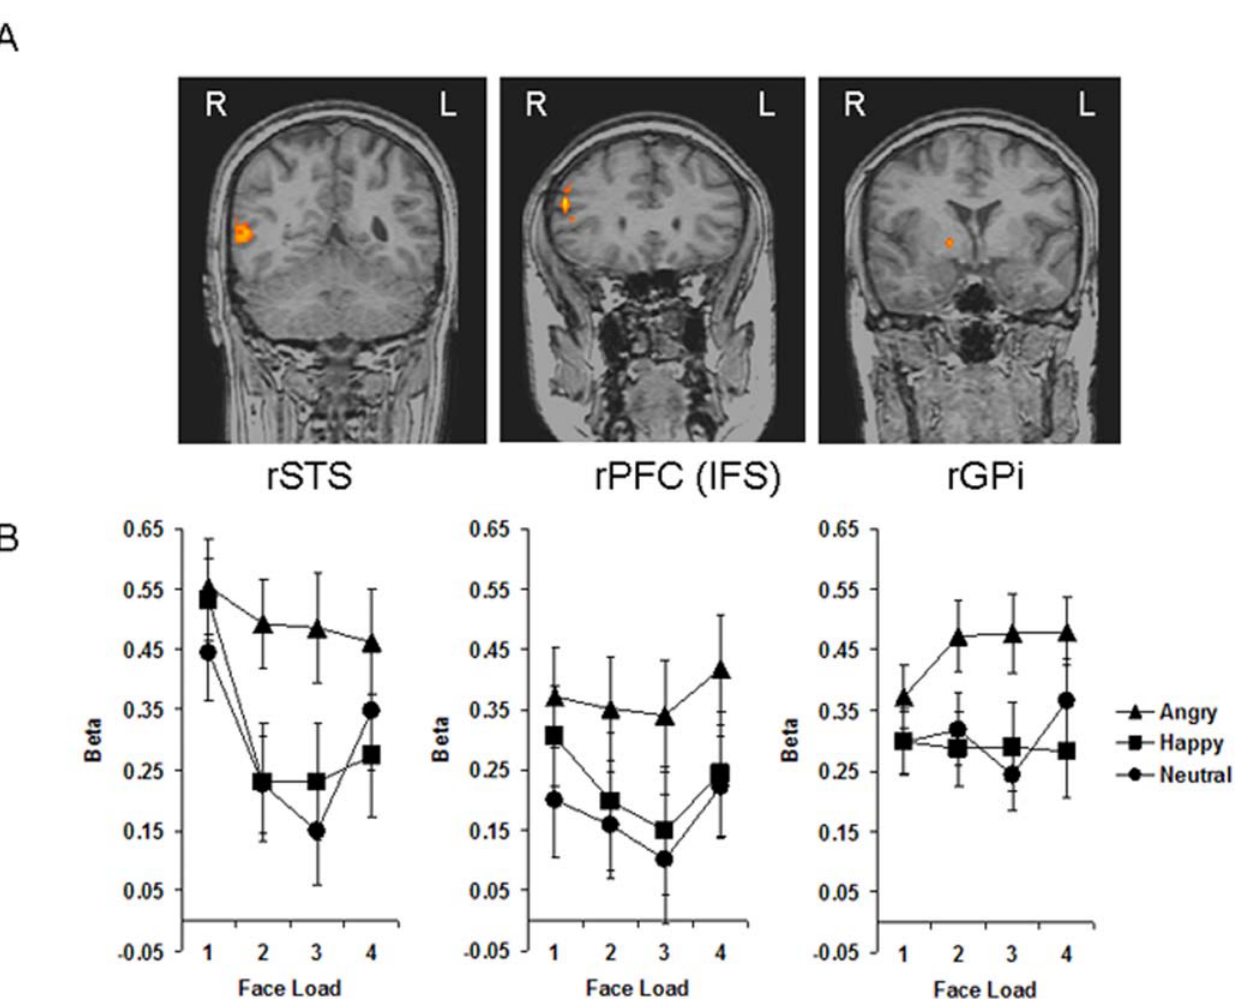
Figure 3. (A) Three coronal brain slices show modulation of brain activity by emotional expression of faces in the VSTM task in the superior temporal sulcus (STS), prefrontal cortex (PFC) along the inferior frontal sulcus (IFS), and globus pallidus internus (GPi), all in the right hemisphere. (B) Beta values for each emotion and face load condition are plotted for the STS, PFC, and GPi. Activity is greater for angry vs. happy and neutral face expression conditions in all three brain regions. Bars represent 6 1 standard error.